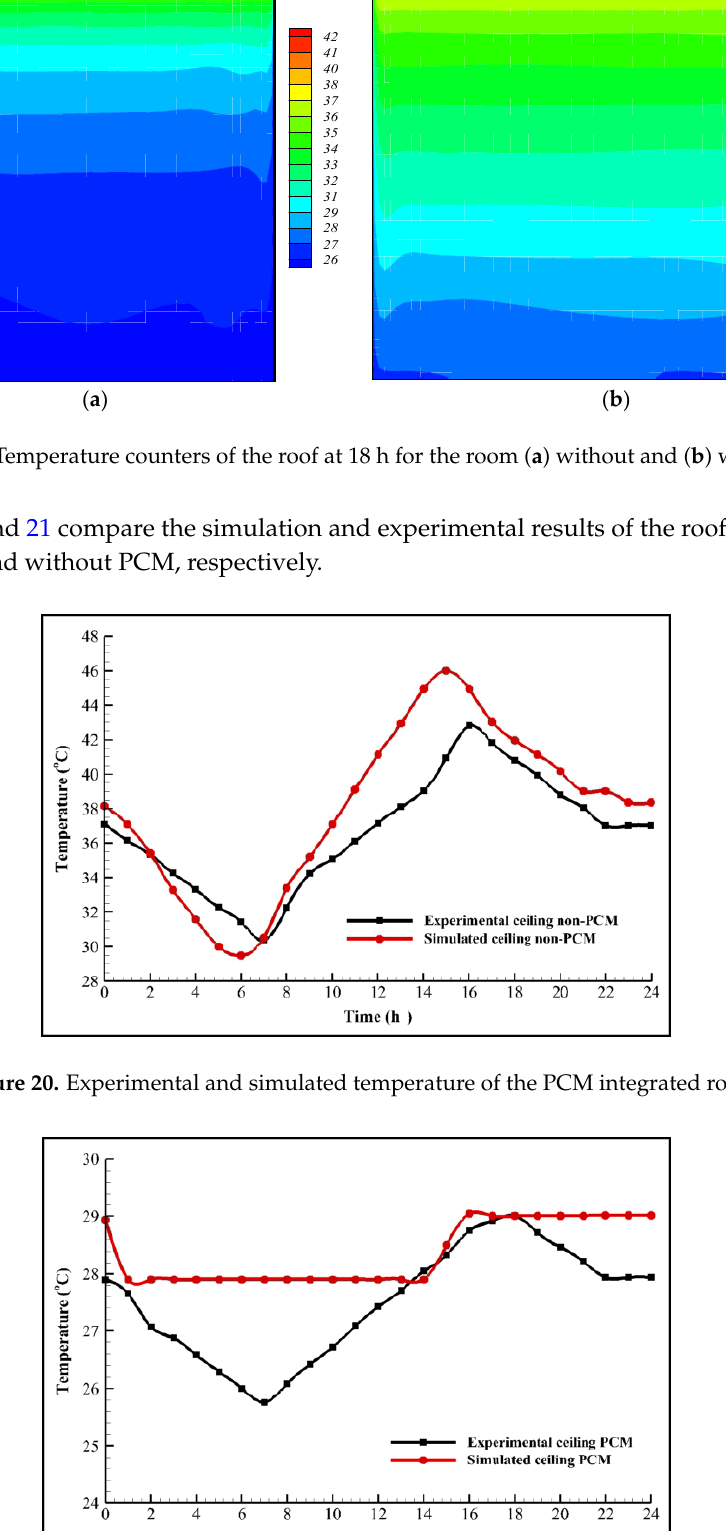
Figure 18. Temperature counters of the roof at 16 h for the room: ( a ) without and ( b ) with PCM.